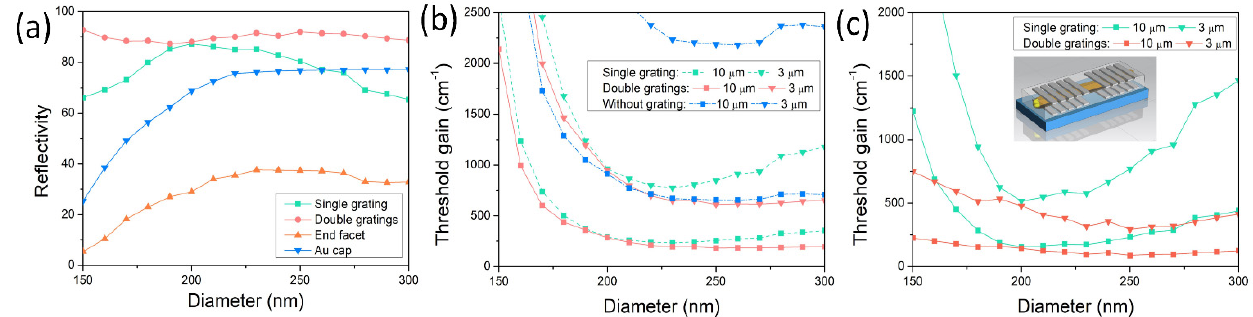
Figure 7. Reflective and threshold gain properties for different nanowire diameters. ( a ) Reflective spectra as functions of nanowire diameter for nanowire on single grating, in sandwiched double gratings, bare nanowire end facet and Au cap. ( b ) Threshold gain as functions of nanowire diameter for nanowire with length of 3 and 10 μ m on single grating, sandwiched in double gratings and without grating. ( c ) Threshold gain as functions of nanowire diameter for nanowire with length of 3 and 10 µ m on symmetric single gratings and symmetrically double gratings. The number of grating periods is 10.